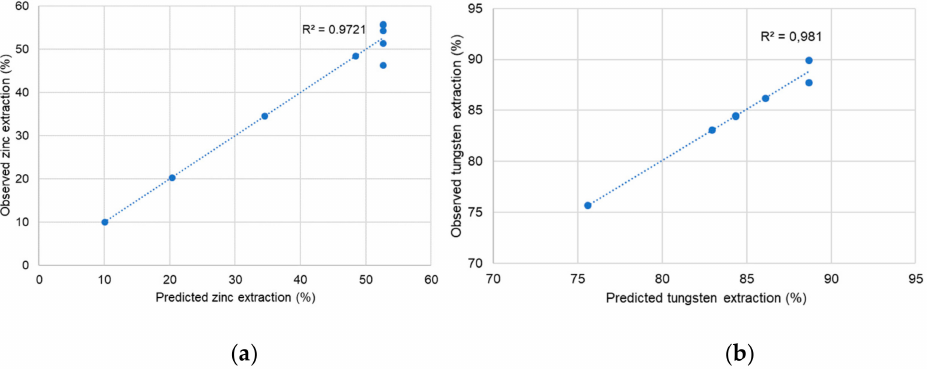
Figure 4. ( a ) Observed versus predicted responses of zinc extraction; ( b ) observed versus predicted responses of tungsten